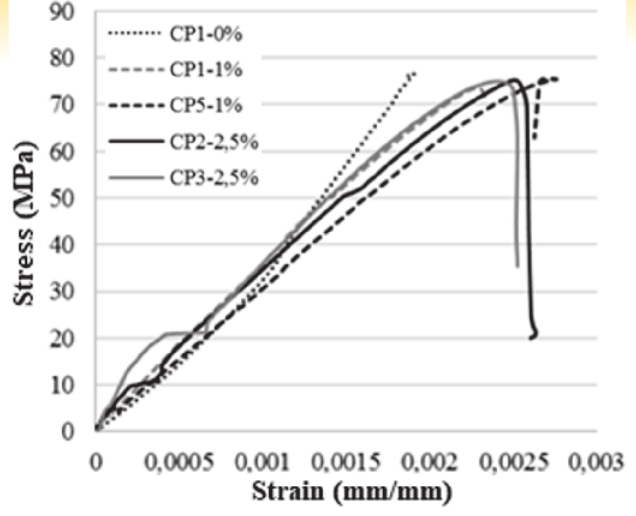
Stress x strain curves of the concrete specimens after compression tests (Author)